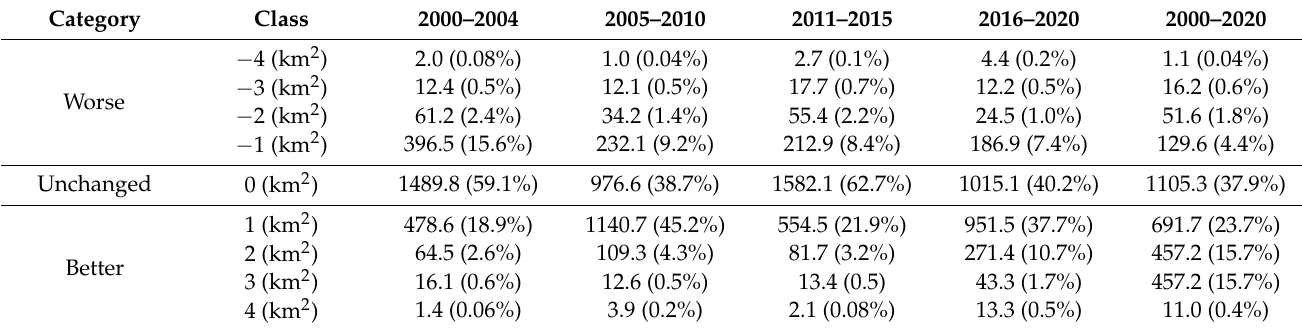
Table 6. RSEI class and area